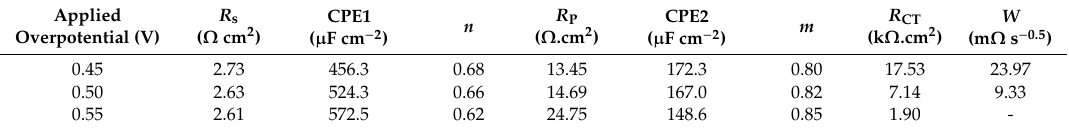
Table 1. Fitting parameters obtained by using the electrical equivalent circuit, shown in Figure 6C, for Nyquist plots of GC / Sr 2 PdO 3 in 0.1 M HClO 4 solution, at di ff erent applied overpotentials. R s R P R CT Applied W CPE1 CPE2 n m Overpotential (V) ( Ω cm 2 ) ( Ω .cm 2 ) (k Ω .cm 2 ) ( µ F cm − 2 ) ( µ F cm − 2 ) (m Ω s − 0.5 ) 0.45 2.73 456.3 0.68 13.45 172.3